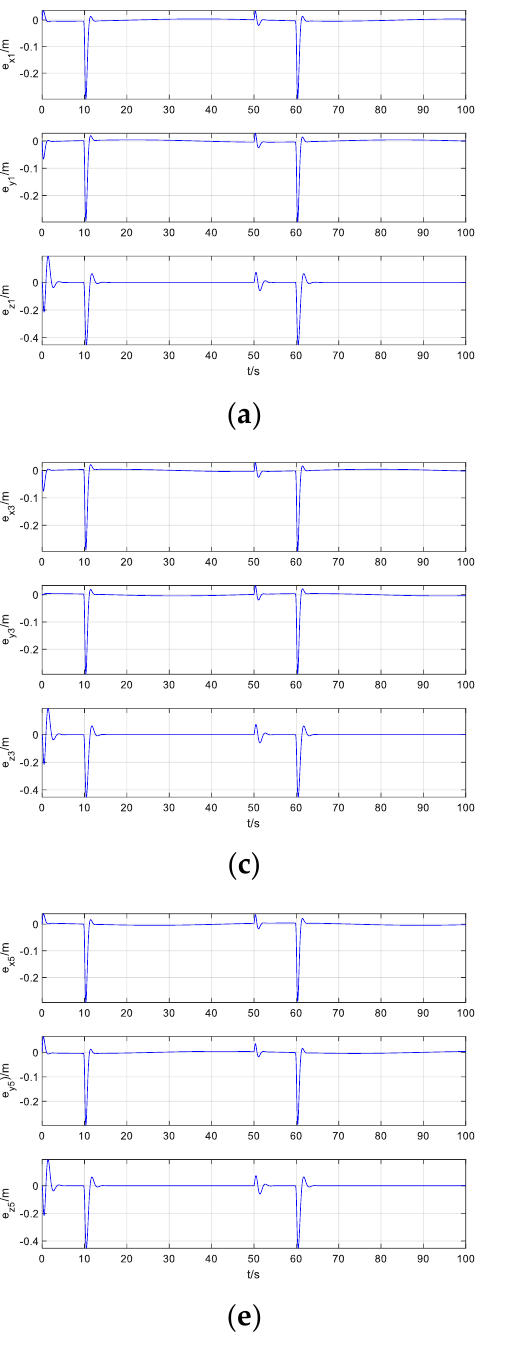
Figure 10. Follower1-Follower6 tracking error when use PD control: ( a ) Follower1; ( b ) Follower2; ( c ) Follower3 ; ( d ) Follower4; ( e ) Follower5; ( f ) Follower6.